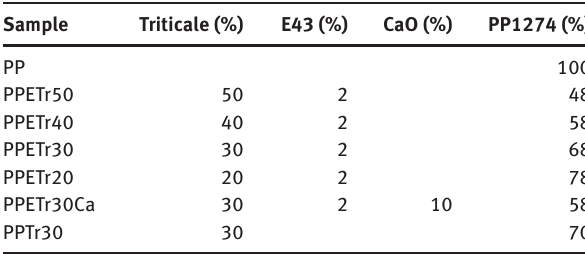
Table 1 Formulation for composites.